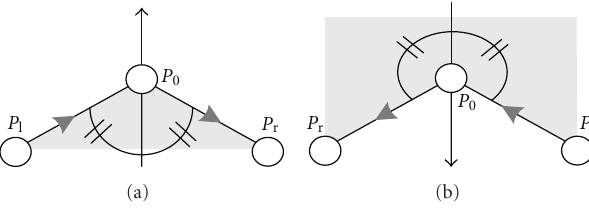
Figure 2: Front tracking and markers. Circles represent markers along the fire line. Arrows show the propagation vector (bisector of the local angle at the marker P 0 between the left point P l and the right point, P r ). The grey area represents the burned fuel.